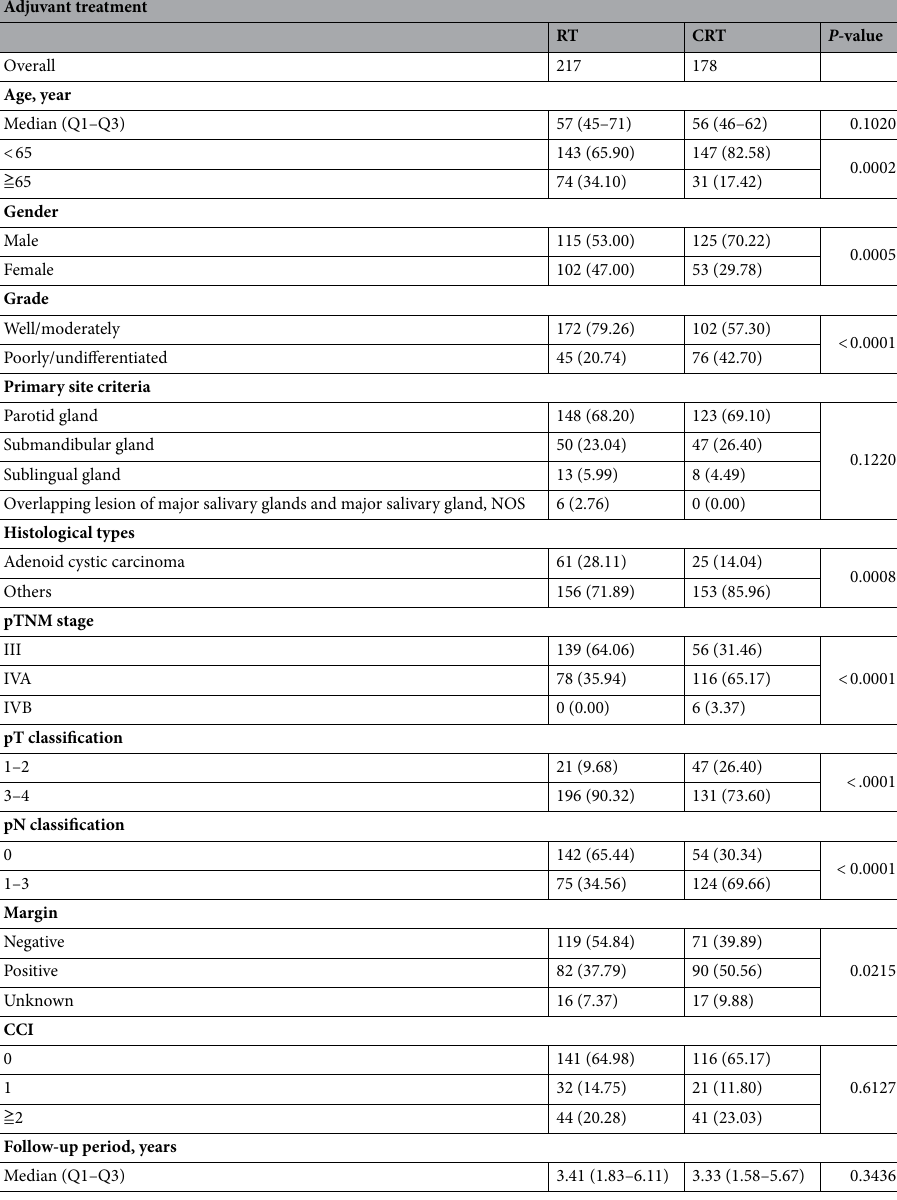
Table 1. Patient and treatment characteristics of advanced major salivary gland cancer patients, n = 395. RT radiotherapy, CRT chemoradiotherapy, CCI Charlson Comorbidity Index. P -value was calculated from Pearson’s Chi-square for categorical variables and Wilcoxon rank sum test was used to comparing the medians between the two